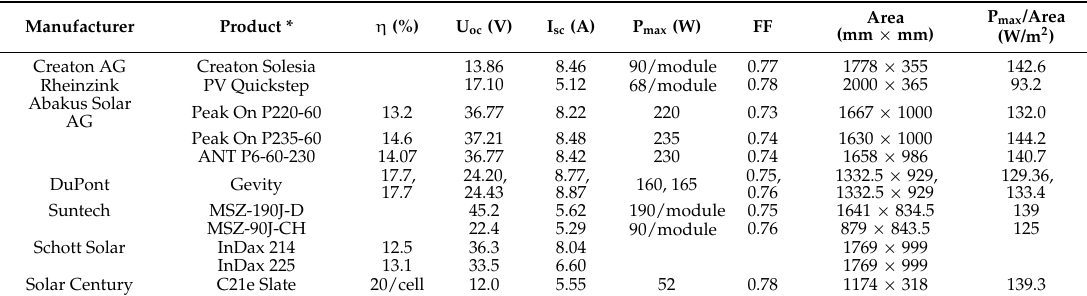
Table 3. Literature data for some of the BIPV module products [3].